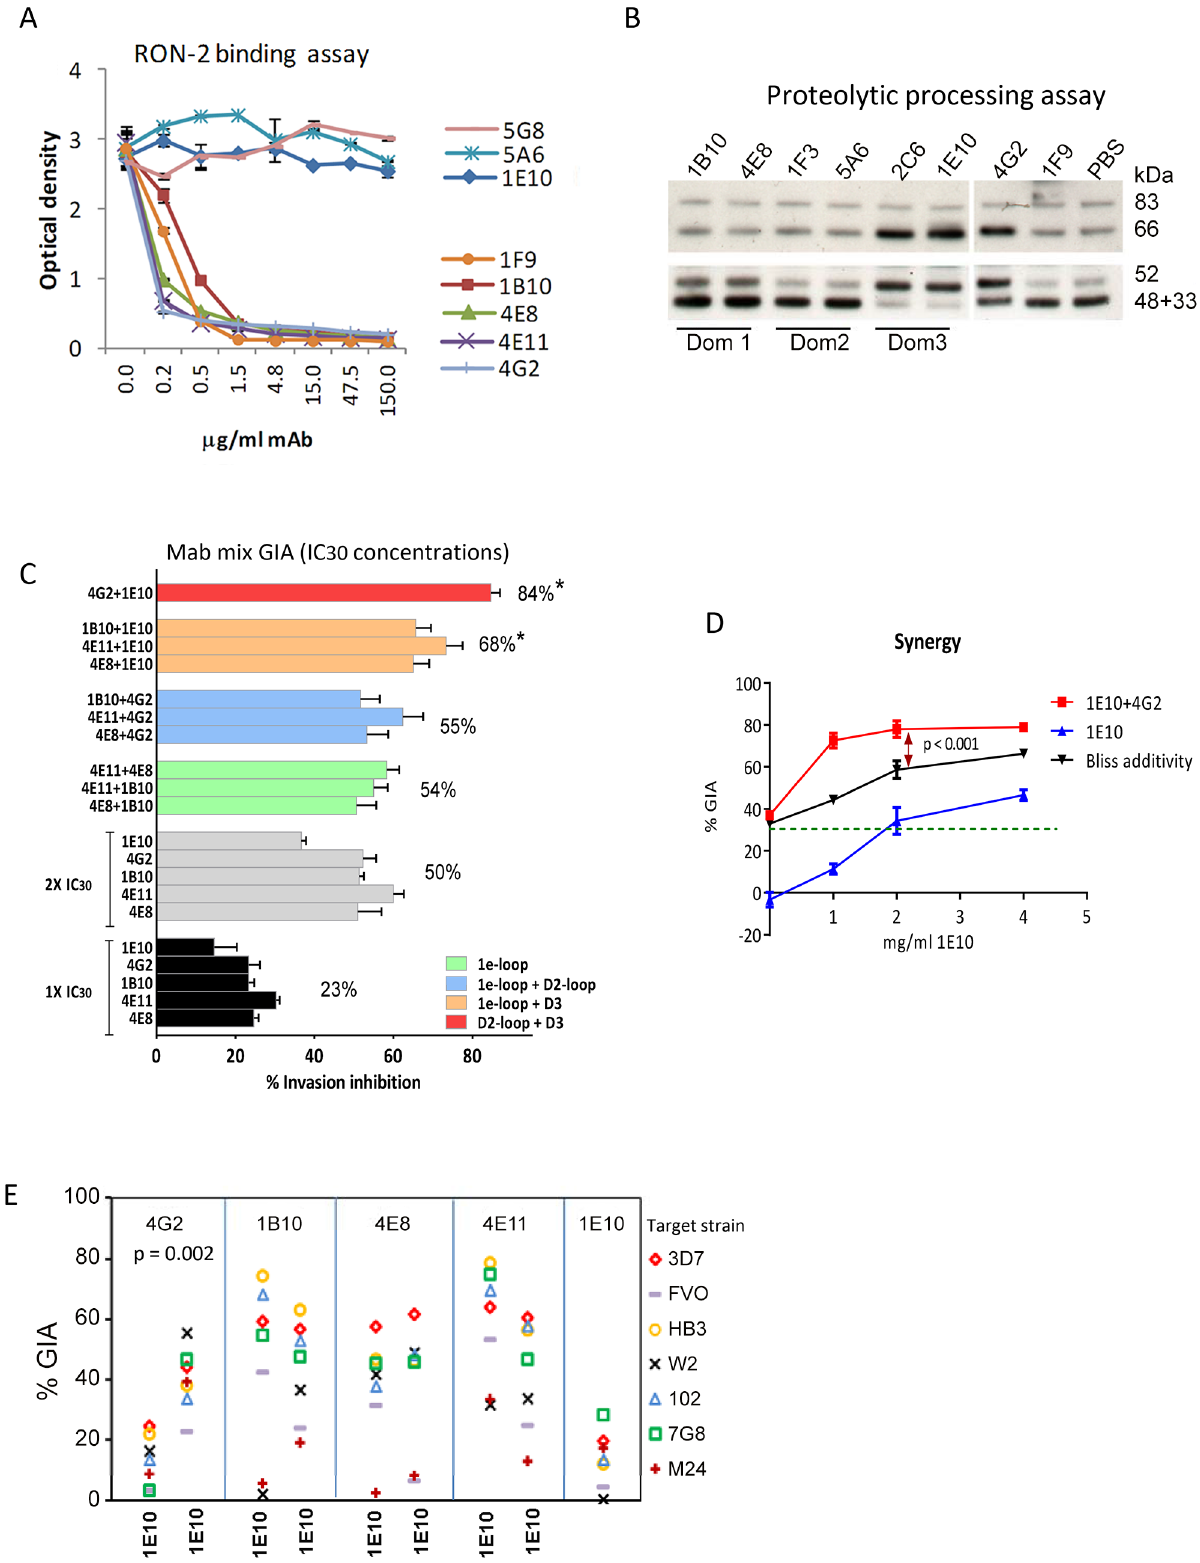
Figure 5. Biological activity of monoclonal antibodies. ( A ) Binding of 3D7 AMA1 (OD 450 ) to immobilized RON2 peptide inhibited by serial dilutions of the mAbs. Negative control mAb 5G8 binds to the N-terminal prosequence. ( B ) Western blot of a 3D7 parasite processing inhibition assay using 200 m g/ml mAbs. Top panel shows the merozoite bound full-length (83 kDa) 3D7 parasite AMA1 and the product of N-terminal processing